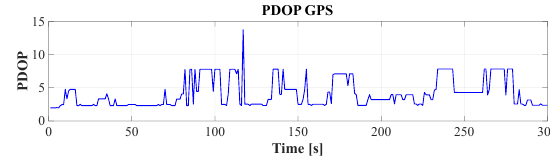
Figure 9. GPS PDOP values. Vehicle 1